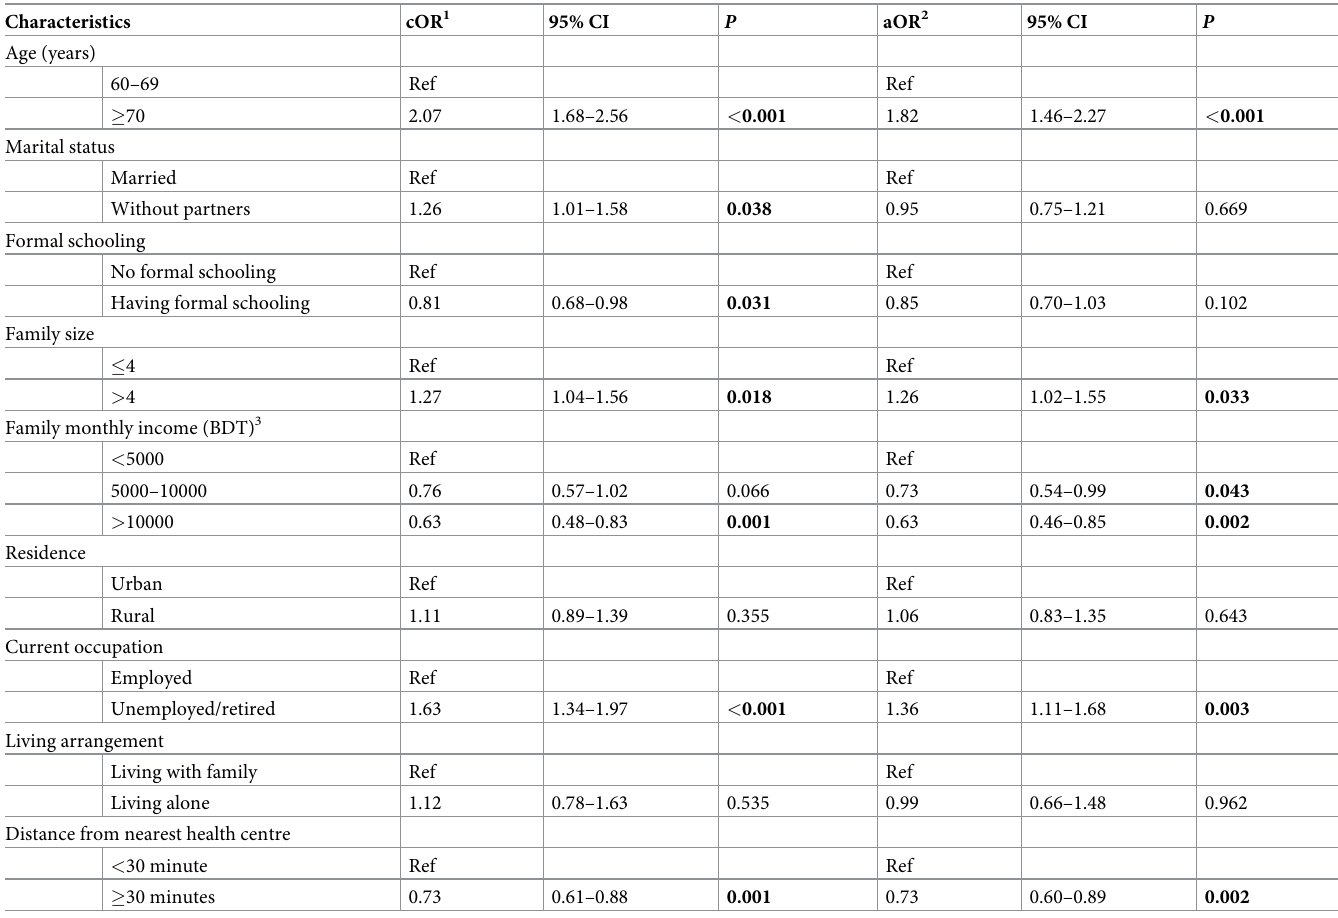
1 Crude Odds Ratio; 2 Adjusted Odds Ratio; 3 1 BDT ~ 0.011